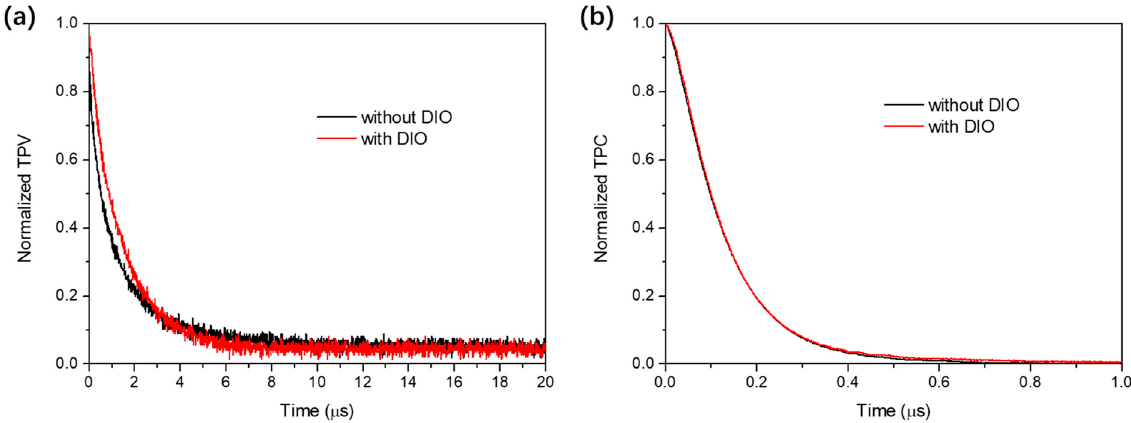
Figure 7. Normalized ( a ) TPV and ( b ) TPC curves of PM6:BTP − eC9 − based ssNP devices with or without DIO.